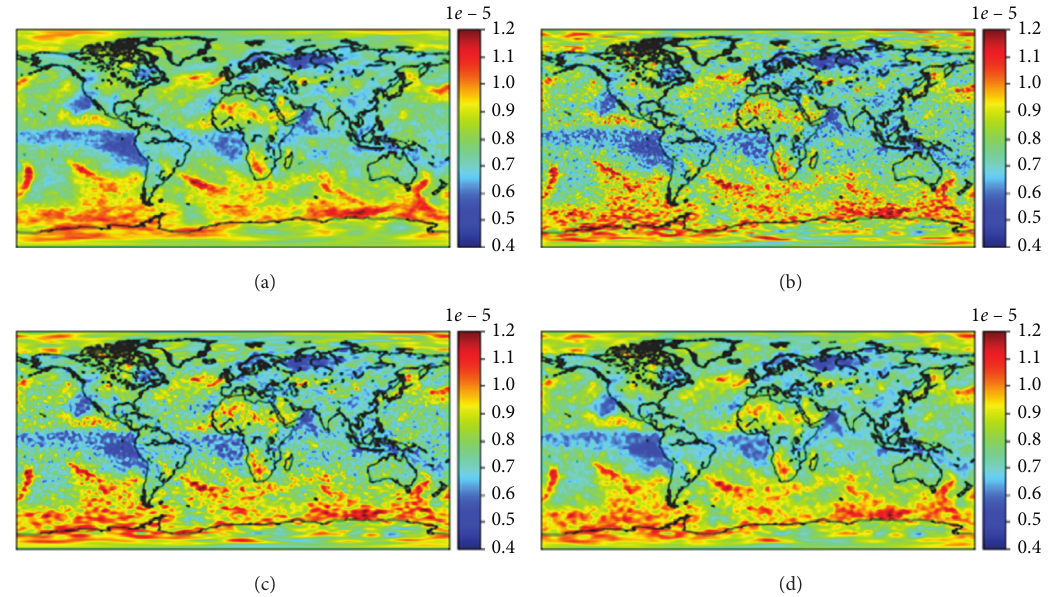
Figure 7: The vorticity standard deviation field at 1000hPa estimated from (a) 1000 samples, (b) 50 samples, (c) filtered 50 samples with � 1000, and (d) spatially averaged 50 samples with the averaging length L � 500km. N tr